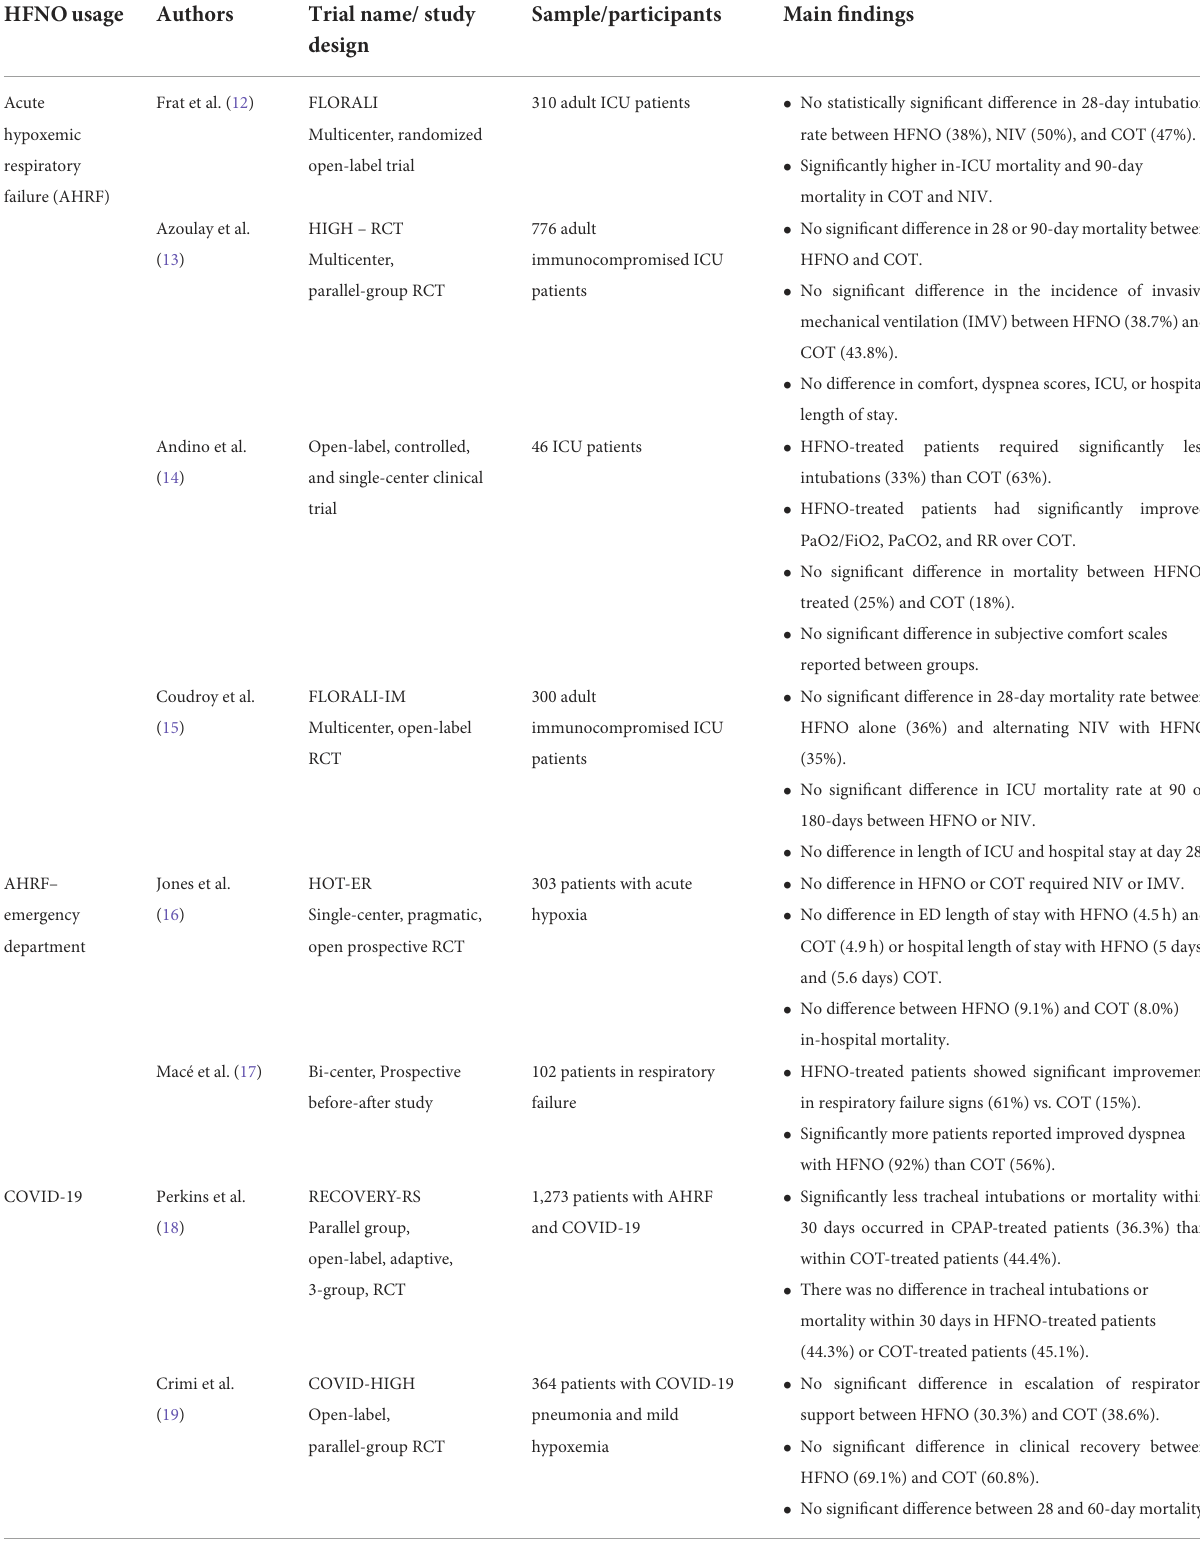
TABLE 1 Overview of key clinical trials and studies.